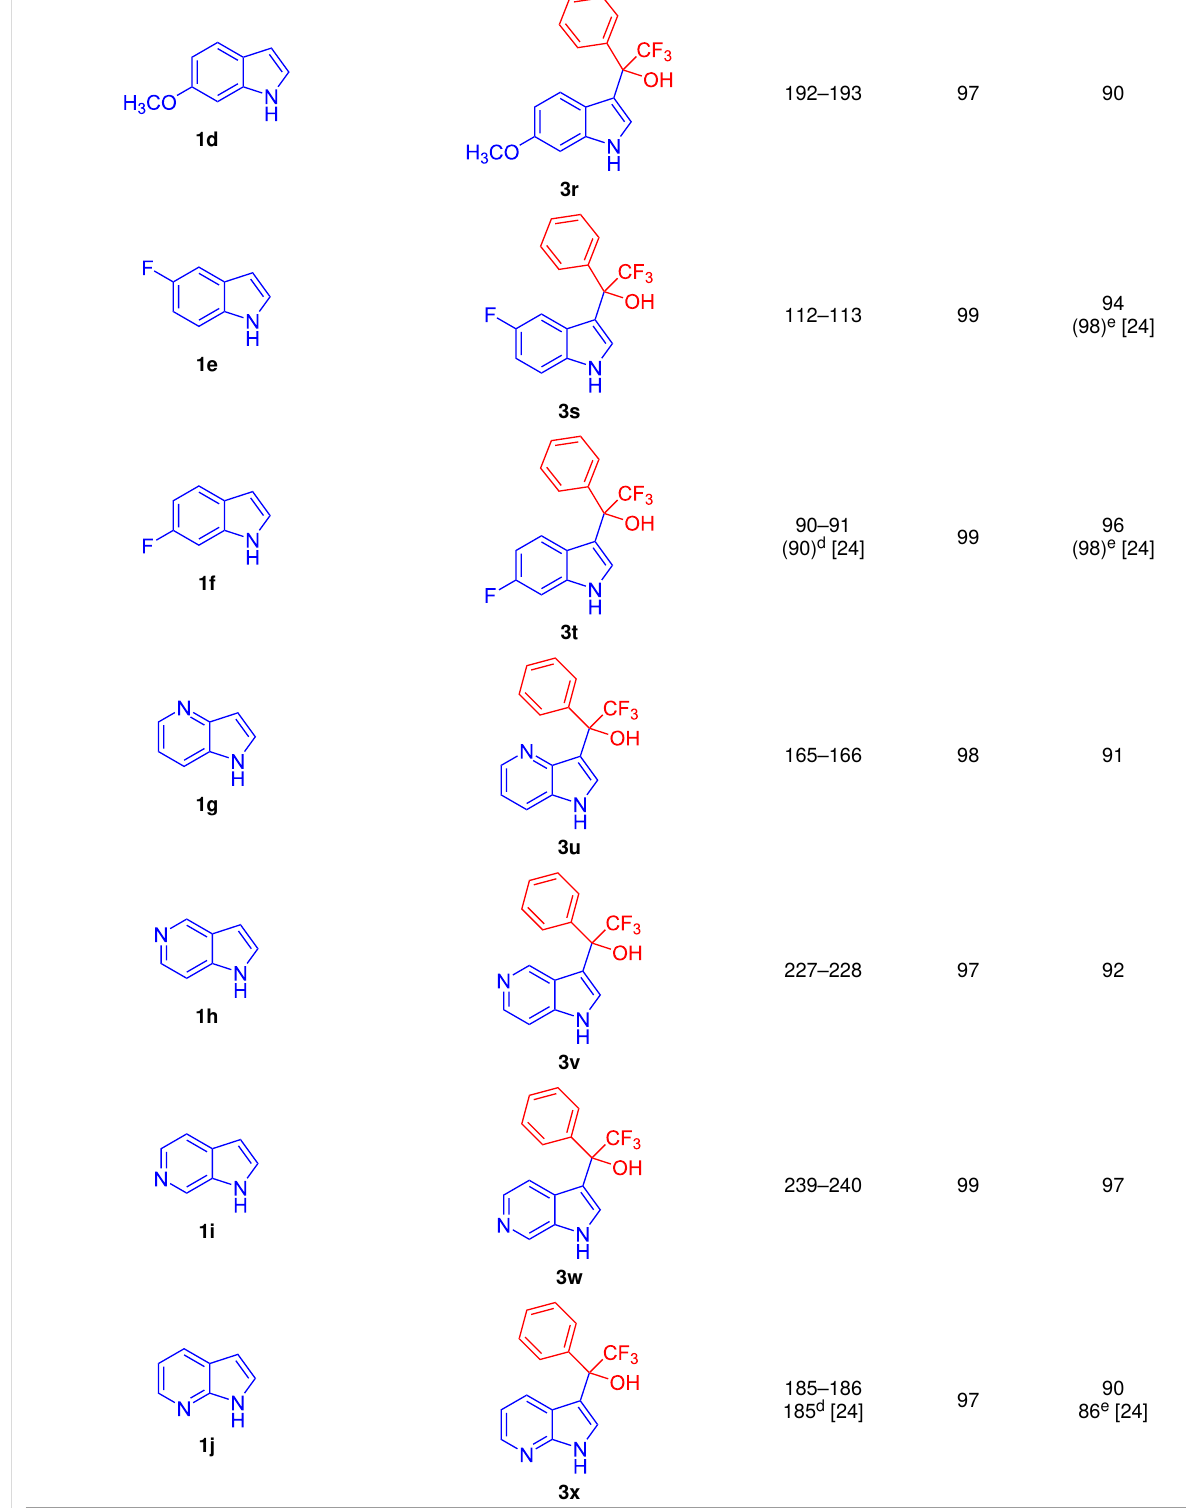
Table 3: Substrate scope of the reaction with indoles. a